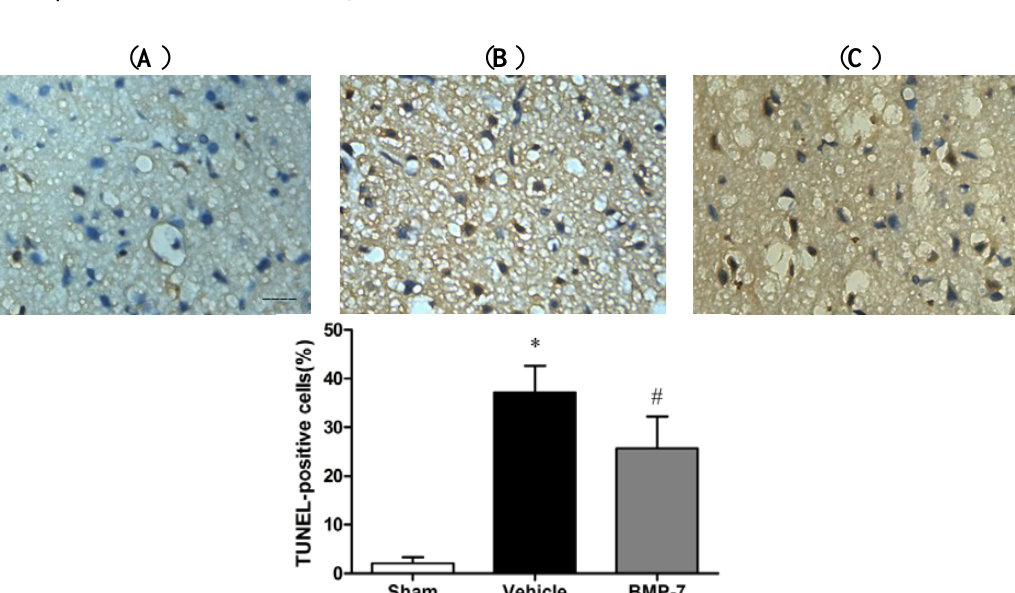
Figure 5. BMP-7 protect neuronal cell against cerebral ischemia-induced apoptosis. The TUNEL-positive apoptotic cells were labeled brown in nuclei (scale bar = 20 μm). ( A ) sham group; ( B ) vehicle group; and ( C ) BMP-7 group; Apoptotic rates significant increased at 24 h after reperfusion in the vehicle group. BMP-7 treatment could decrease apoptotic rate. The apoptotic rate was calculated as percentage of apoptotic cells among total nerve cells, and data were expressed as mean ± SD ( n = 10). * p < 0.05 versus sham group; # p < 0.05 versus vehicle